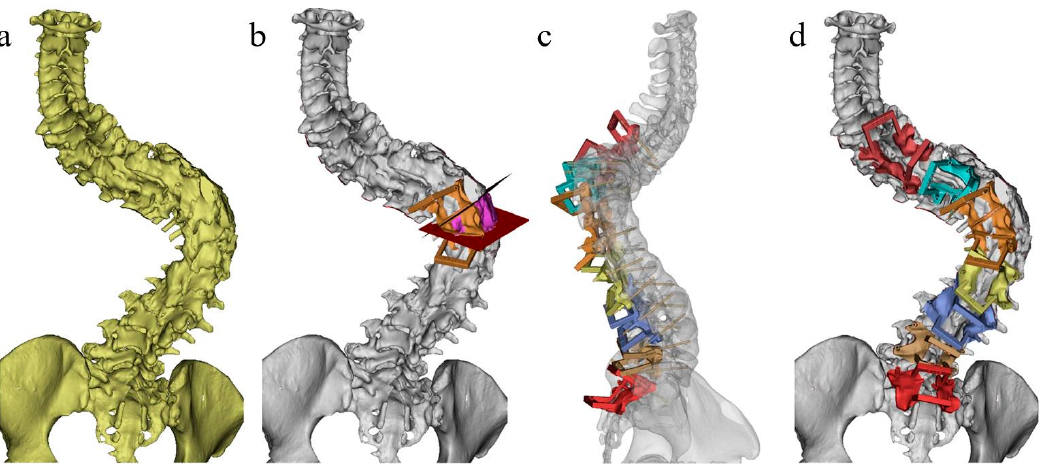
Figure 2. Design of osteotomy guidance templates. ( a ) Three-dimensional construction of spine; ( b ) design of osteotomy plane; ( c ) design of screw trajectory and guidance templates, making the osteotomy guide rail overlap with the osteotomy plane; ( d ) osteotomy and screw insertion guidance templates.